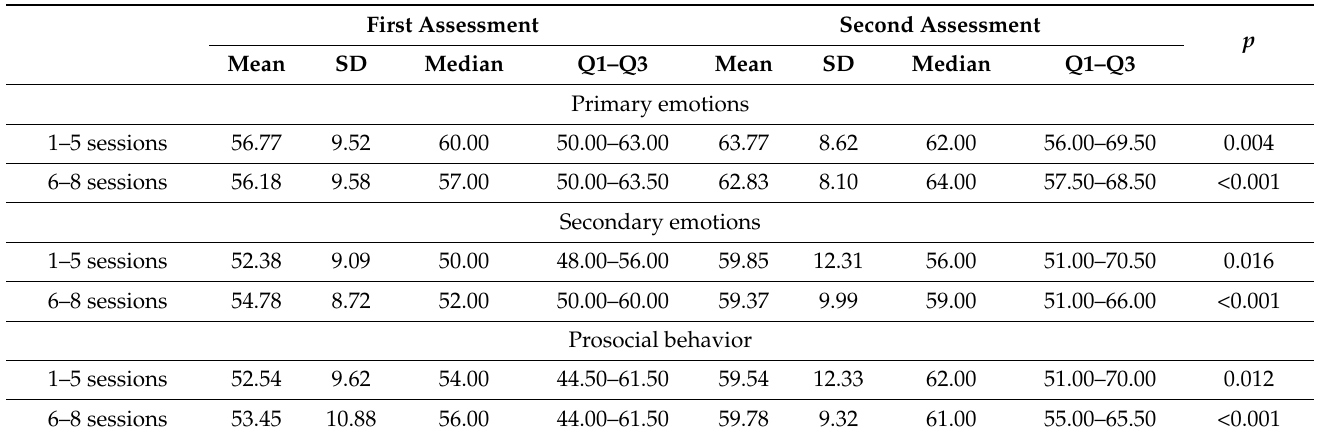
Table 11. Changes in the results of the EMK 3–6 in separate subscales, comparing the data of the first and second assessments in the experimental group, which were formed according to the number of sessions